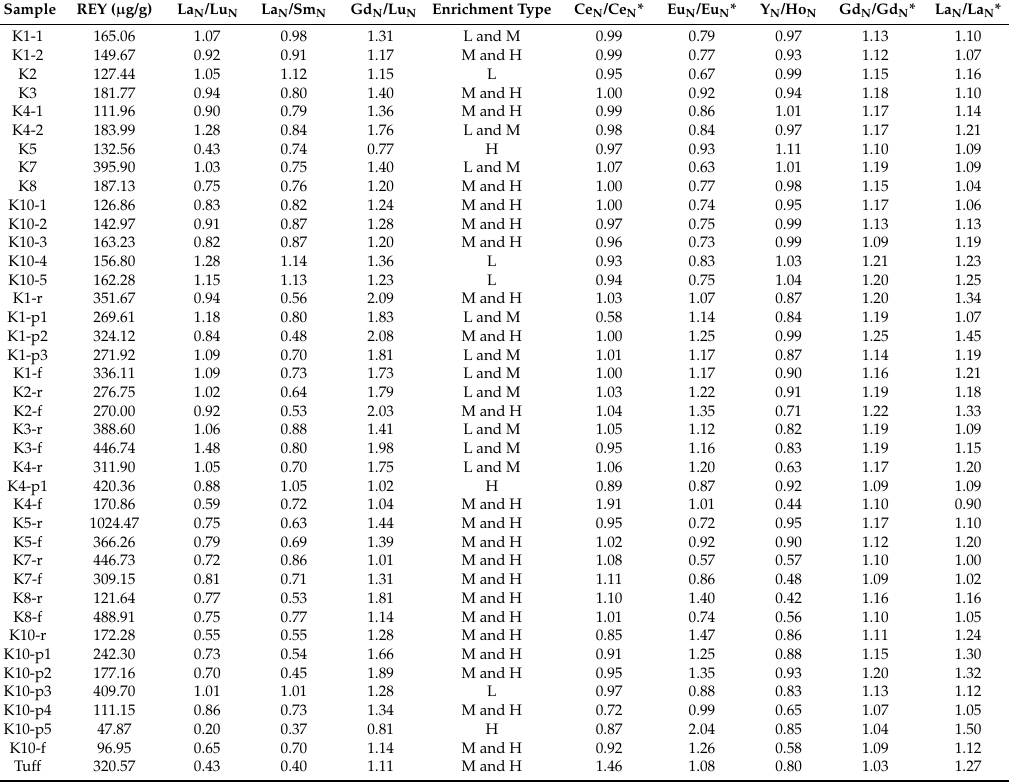
Table 5. REY parameters in the coal and non-coal samples from the ZK4-1 drill core in the Zhongliangshan